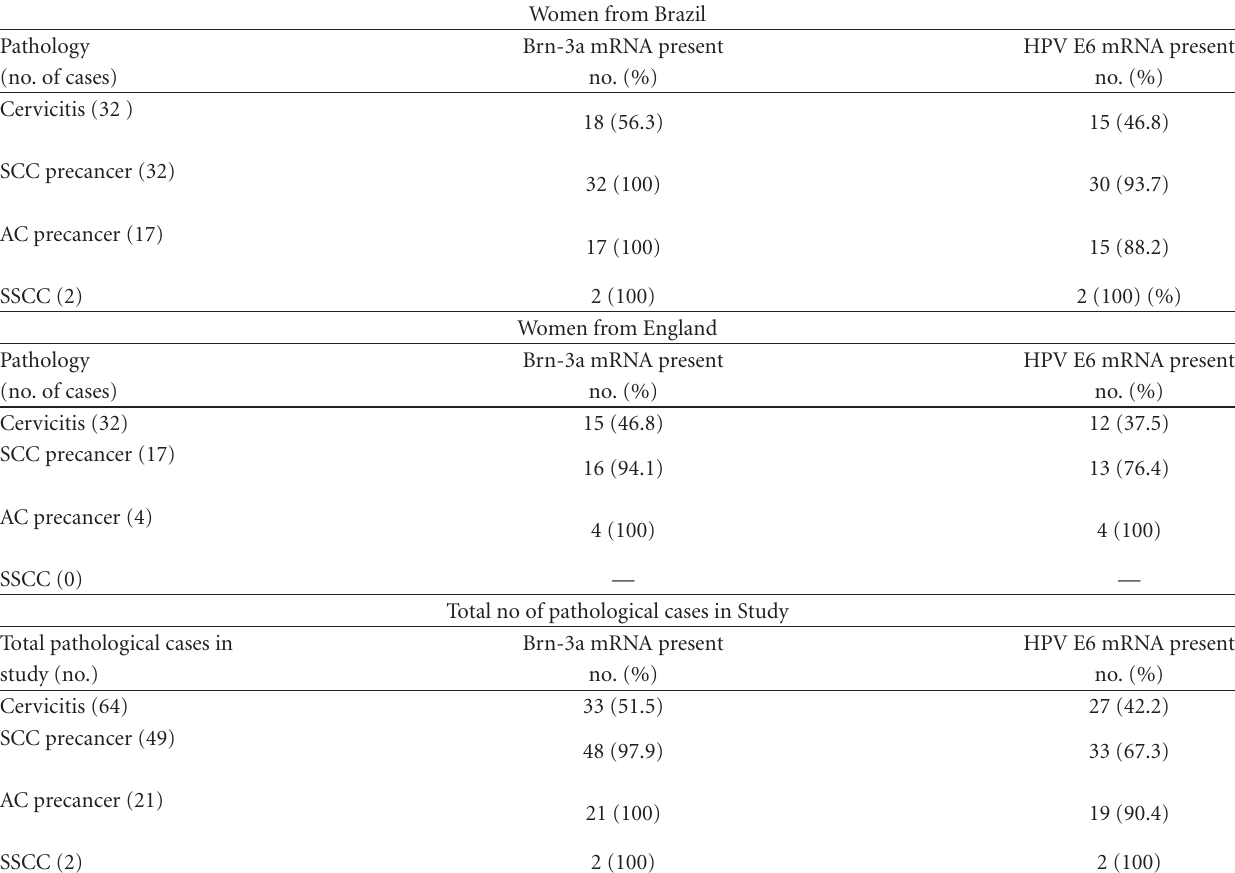
Table 2: Presence of Brn-3a and E6 mRNA in the cervix of women in Recife-Brazil with di ff erent forms of cervical precancer lesions and a cervicitis control